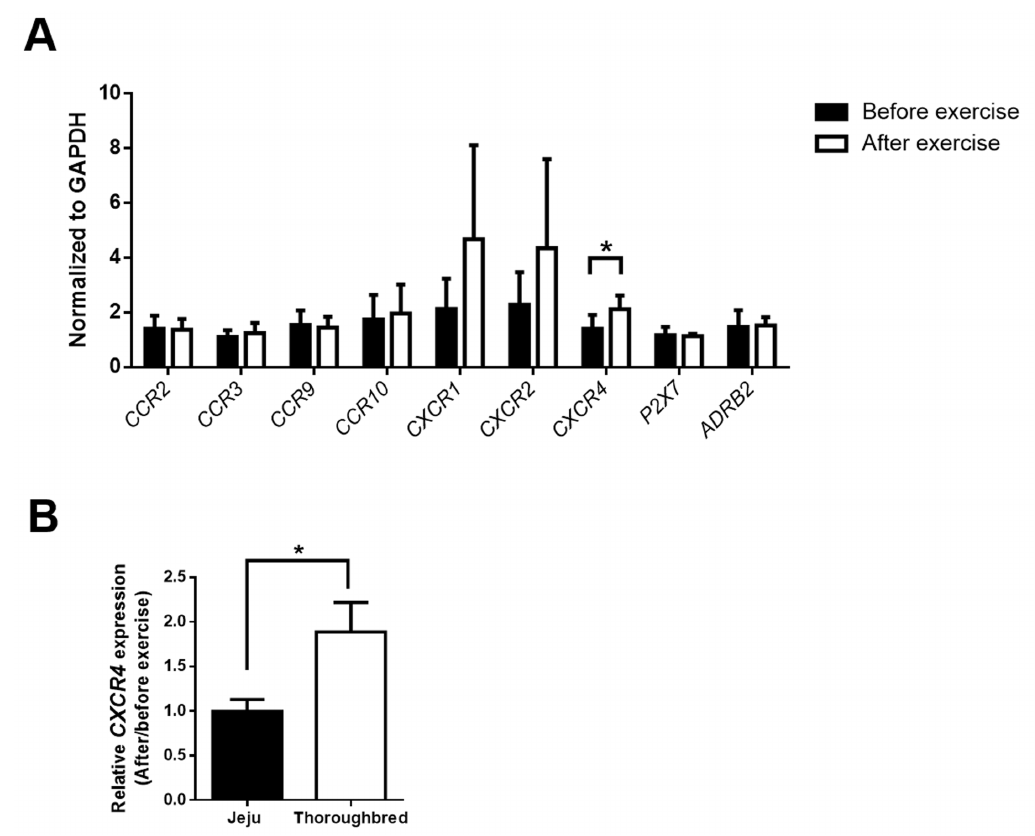
Figure 5. Exercise triggered the upregulation of CXCR4 expression in the peripheral blood mononuclear cells (PBMCs) of Thoroughbred horses. Jeju and Thoroughbred horses were exercised for 30 min. Blood samples were collected and PBMCs were separated using Polymorphprep gradient centrifugation. mRNA was extracted from PBMCs and reversed to form cDNA to the determine the expression of chemokine receptor genes. (A) Results of the real-time PCR of various chemokine receptor genes. Data from Thoroughbred horses are indicated by black and white bars representing data from before and after exercise, respectively. (B) The relative CXCR4 gene expression of the two breeds as shown by black and white bars representing data from Jeju and Thoroughbred horses, respectively. Data are presented as means±standard error of the mean (n = 5 per breed; * p<0.05, ** p<0.01, and *** p<0.001, unpaired Student’s t-test). CCR, C-C chemokine receptor; CXCR, CXC chemokine receptor; ADRB2, beta-adrenergic receptor